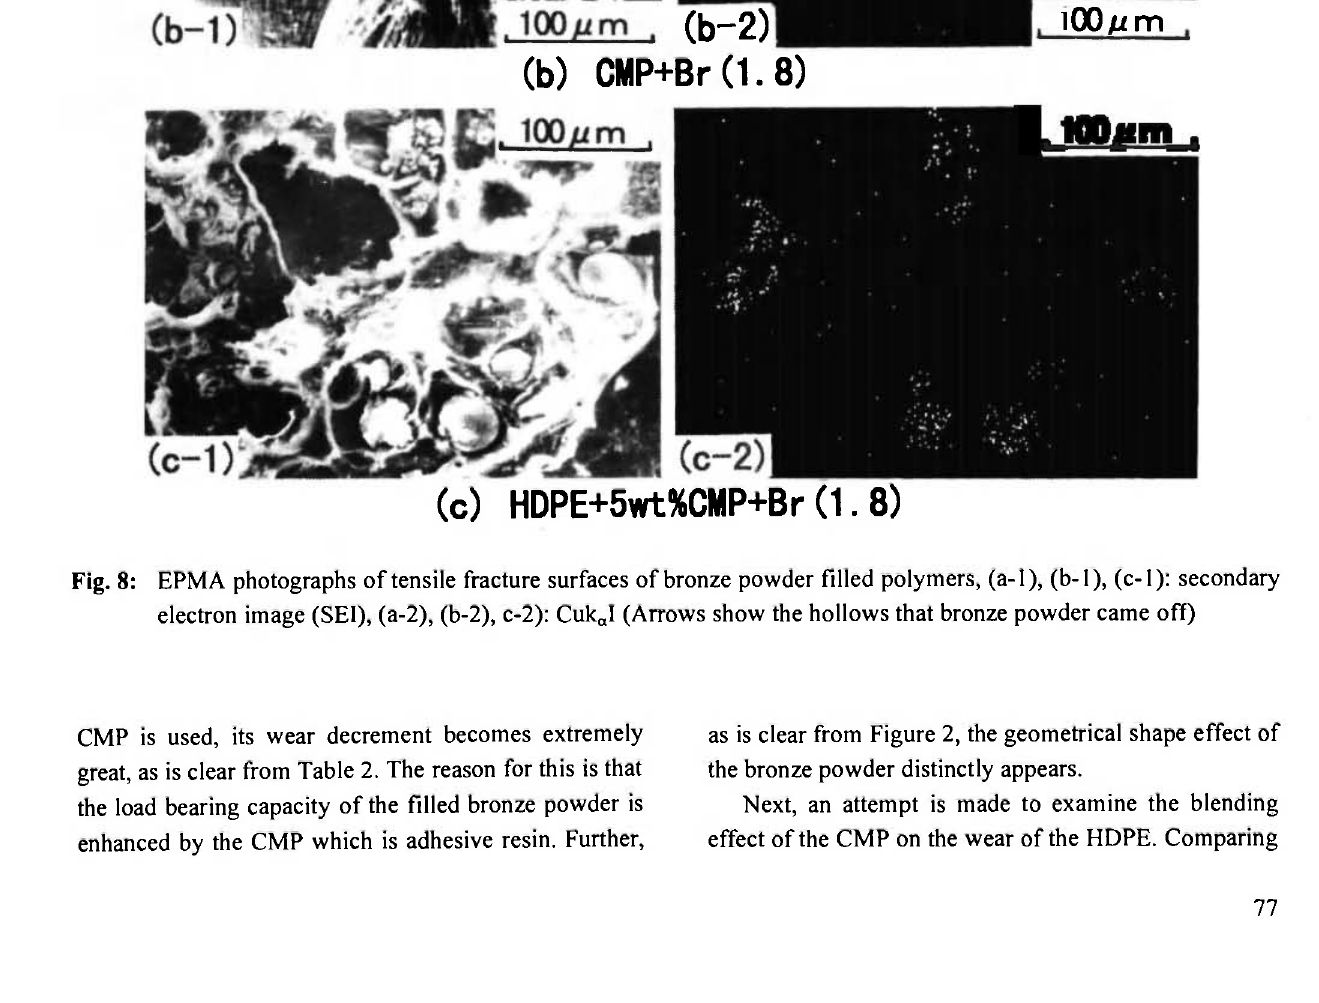
CMP is used, its wear decrement becomes extremely great, as is clear from Table 2. The reason for this is that the load bearing capacity of the filled bronze powder is enhanced by the CMP which is adhesive resin. Further,